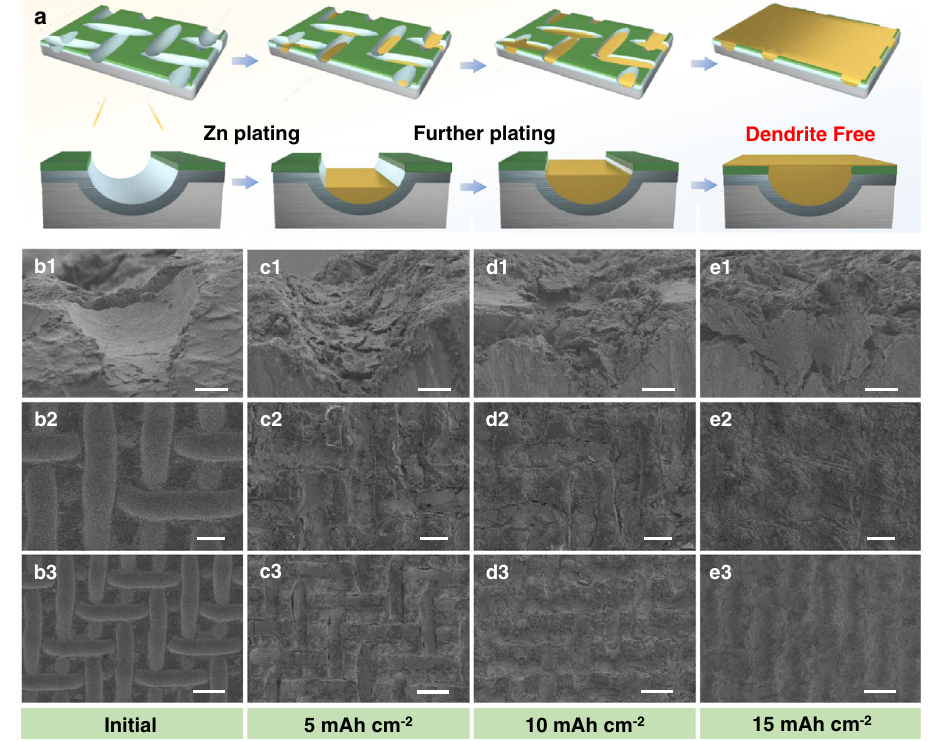
Fig.4|ZndepositionmorphologyofPVDF-Sn@Zngradientelectrode.a Models of PVDF-Sn@Zn gradient electrode with different deposition capacities. SEM ima- gesofPVDF-Sn@ZngradientelectrodeafterZndepositionwithcapacitiesof b1 –